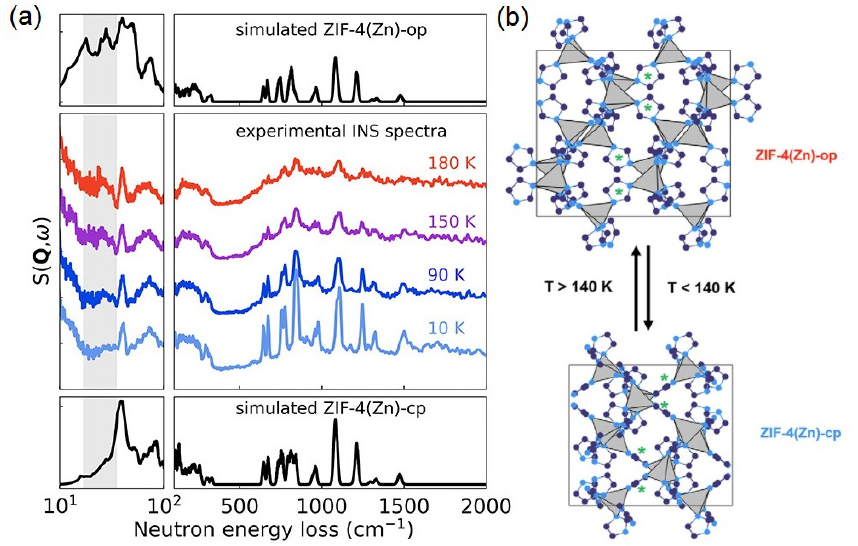
Figure 10. ( a ) Experimental (TOSCA+) and simulated (DFT; VASP) INS spectra of closed- (cp) and open-pore (op) ZIF-4(Zn) structures. ( b ) Schematic diagram of the low-temperature structure of ZIF-4(Zn)-cp and the high-temperature structure ZIF-4(Zn)-op, looking down the b -axis in both phases. A volume contraction of approximately 24% associated with the cp-to-op phase transition is related to a rotation of the imidazolate linkers. Four of such rotations are highlighted by green stars. Reprinted with permission from Ref. [281]. Copyright (2021) American Chemical